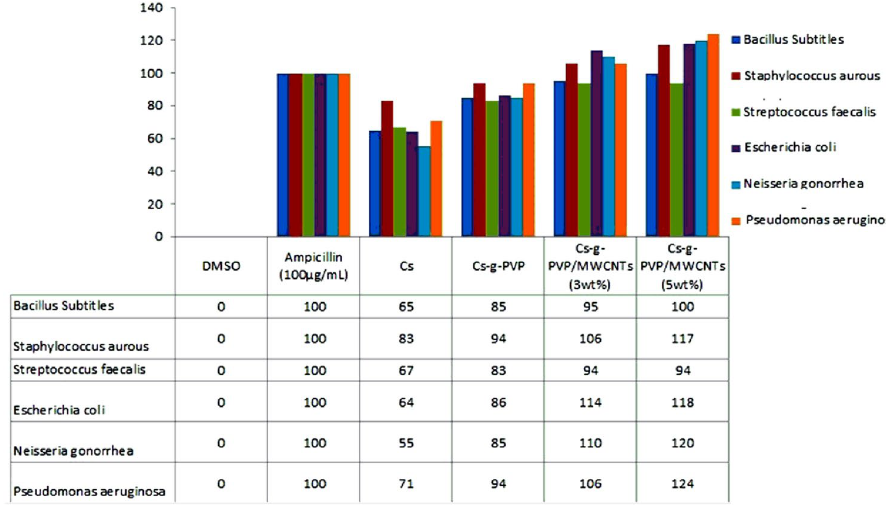
Figure 11. Antibacterial efficiency of the investigated samples with respect to the standard reference